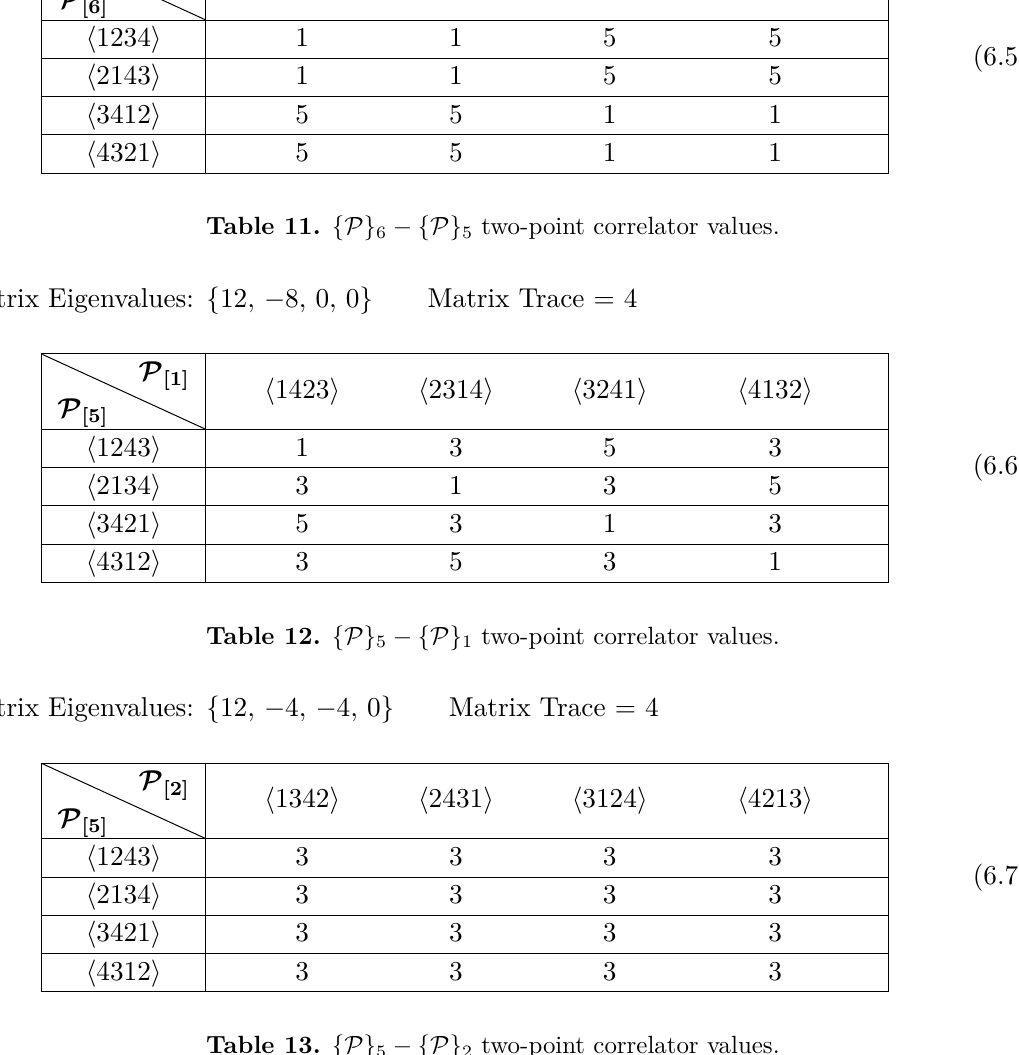
Table 13. {P} 5 − {P} 2 two-point correlator values.